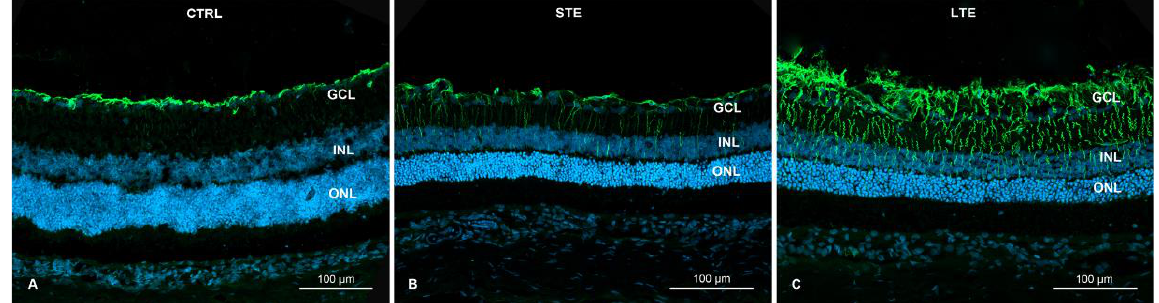
Figure 6. Effect of blue light on glial fibrillary acid (GFAP) protein expression in Wistar rat retinas. The rats were exposed to 12 h white light (150 lx) and 12 h darkness for 10 d (control, CTRL; 9 rats), cycles of 12 h blue light (150 lx) and 12 h darkness for 10 d (long-term exposure, LTE; 9 rats), and constant blue light (150 lx) for 2 d (short-term exposure, STE; 9 rats). ( A ) LTE: Immunolabeling for GFAP in thick Müller cell processes indicating advanced hypertrophy; the immunolabeling extends from the innermost layers of the retina to the outer limiting membrane. ( B ) STE: Immunolabelling for GFAP in Müller cell processes indicating mild hypertrophy. Note thin GFAP-positive fibers extending from innermost layers to the outer plexiform layer. ( C ) GFAP expression in the control retina is limited to the innermost layers (NFL and GCL). Samples were visualized and photographed with a confocal microscope (LSM900, Zeiss). Abbreviations: ONL, outer nuclear layer; INL, inner nuclear layer; GCL, ganglion cell layer.